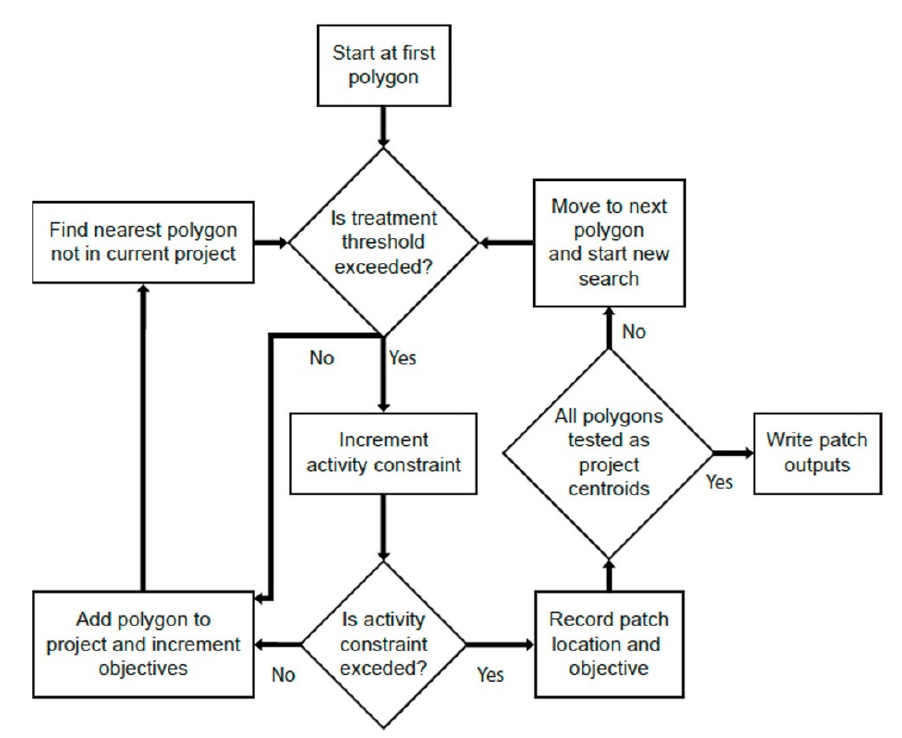
Figure A6. Flowchart of program control for ForSys showing the decision framework for simulations that use the aggregation option, adapted from Ager et al. [21]. Reproduced with permission from Alan Ager; published by USDA Forest Service, Pacific Northwest Research Station,